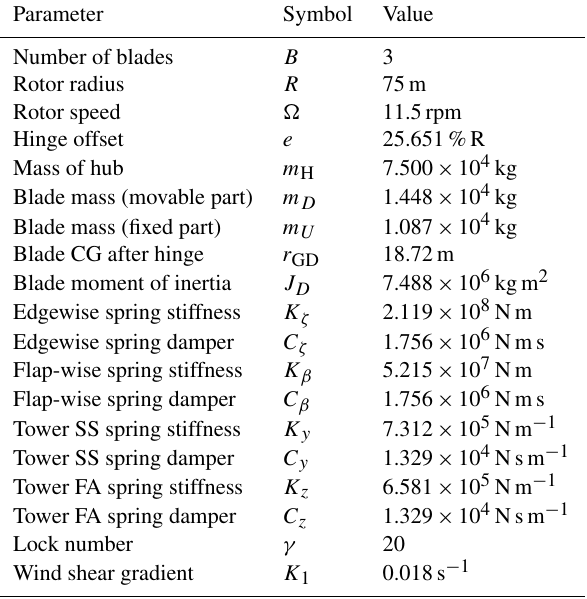
Table 3. Parameters of the analytical wind turbine model.